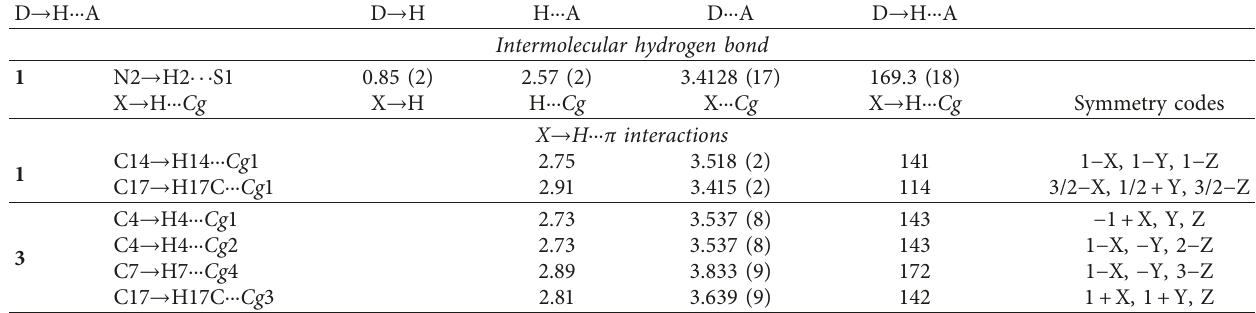
Table 3: Hydrogen bond geometry and intermolecular interactions (˚A, °